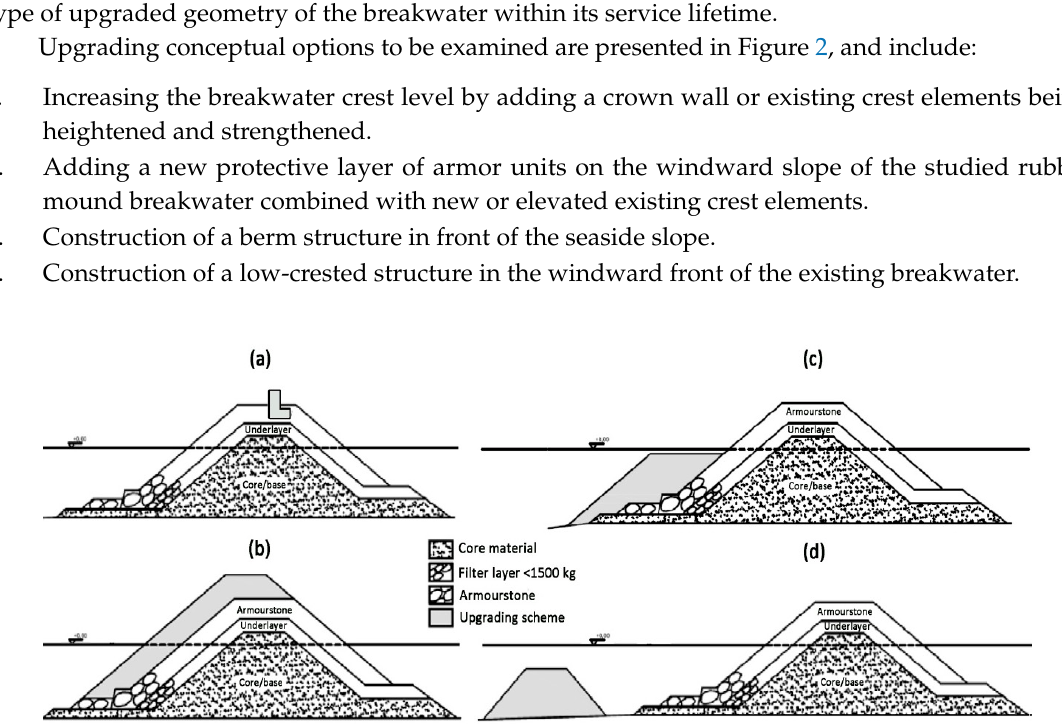
Figure 2. Sketch portrayal of four basic upgrading conceptual options of a rubble mound breakwater used for mitigation against climate change: ( a ) crown wall or heightening of existing crest element; ( b ) additional protective armor layer; ( c ) additional berm on the seaside breakwater slope; ( d ) low-crested structure in front of existing breakwater.